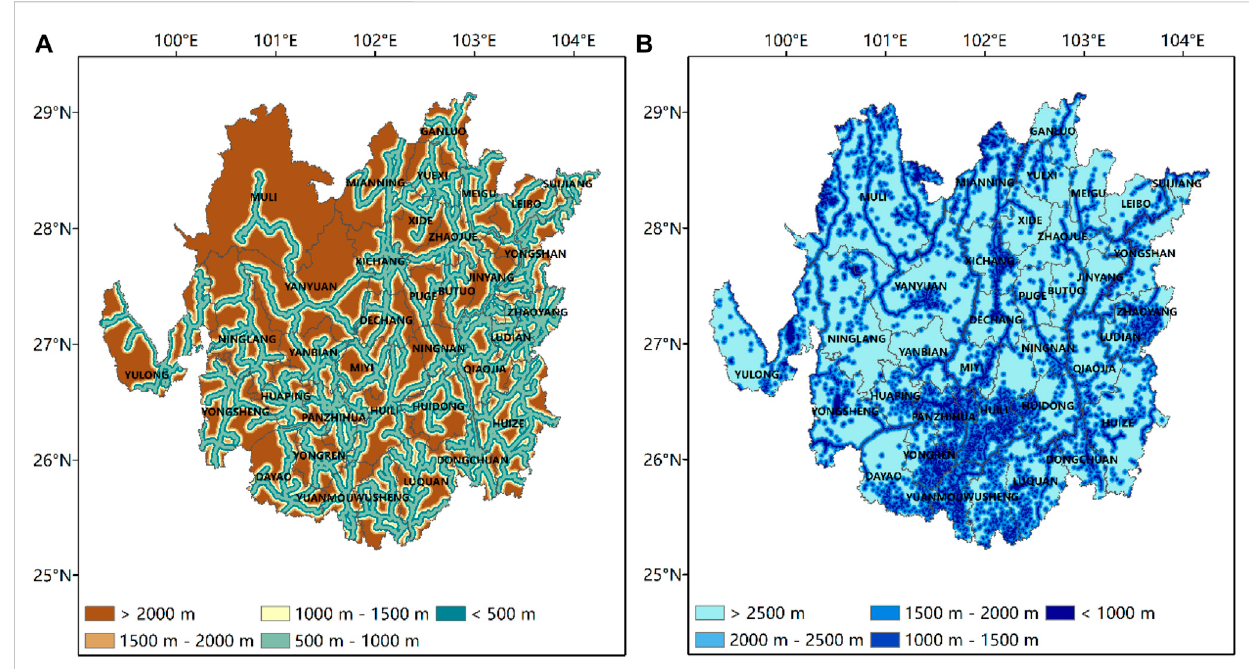
FIGURE 5 Spatialpatternofwild fi reprevention/mitigationcapacityfactorsoverthehigh-wild fi reincidentareainsouthwesternChina. (A) Distancefromroads. (B) Distance from